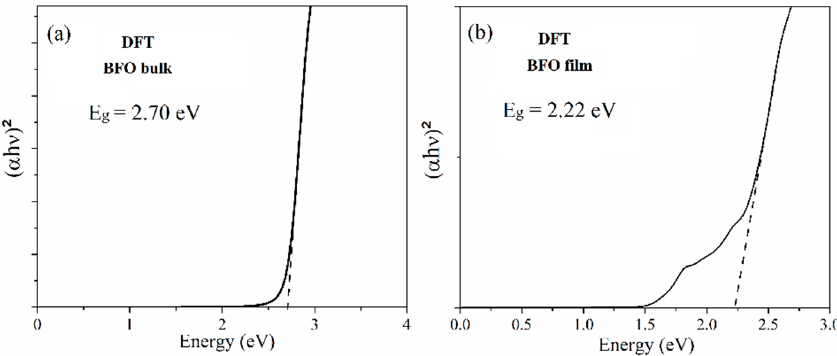
Figure 14. Tauc plot (n = 2, direct band gap) of ( a ) bulk BFO, ( b ) BFO thin film extracted from DFT.